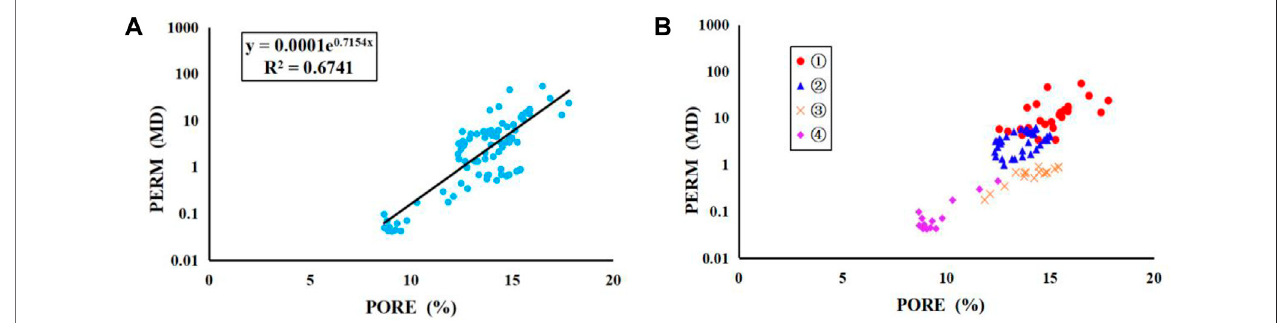
FIGURE 2 | Cross-plot of porosity and permeability of small layer 4 of the Es 3 reservoir [ (A) : overall cross-plot of small layer 4; (B) : separate cross-plot of small layer